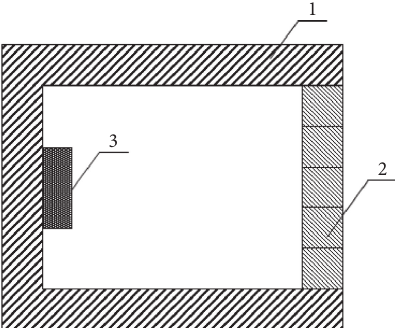
Figure 4: Geometry of the composite material irradiation in the high-energy gamma-radiation flow: 1: protective shield; 2: material samples; and 3: a source of gamma radiation 60 Sp